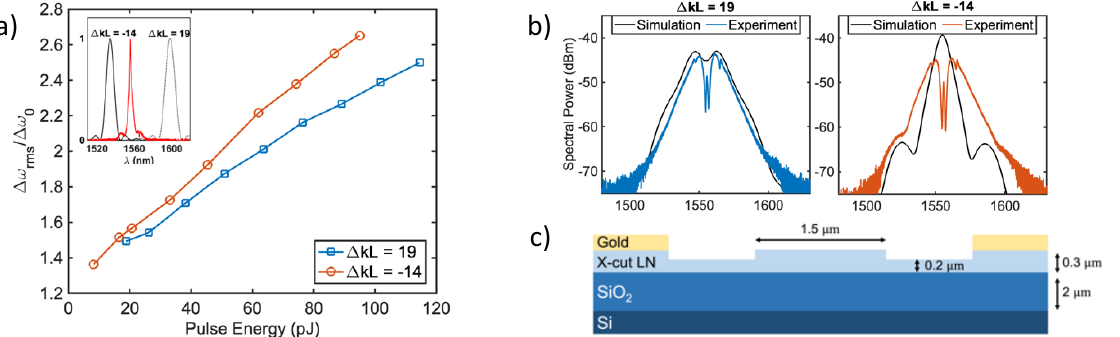
Fig. 1: a) Spectral broadening as a function of input pulse energy for two waveguides with different poling periods. (Inset) Simulated phase matching curves for the waveguides (black) and normalized power spectrum of the input laser (red). b) Simulated and experimentally observed output spectra of pulses for 40 pJ input pulse energies. c) Cross-section of the ridge TFLN